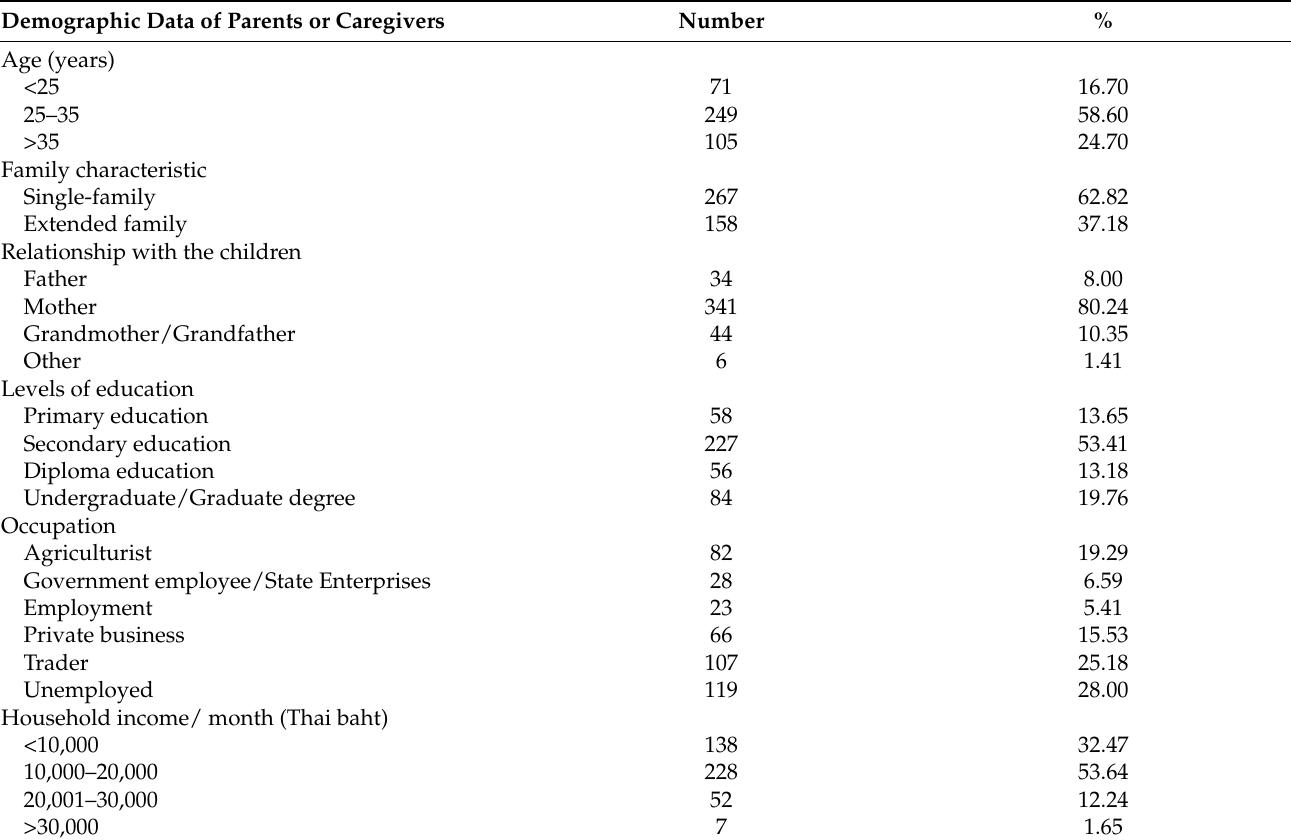
Table 3. The demographic data of parents or caregivers ( n =